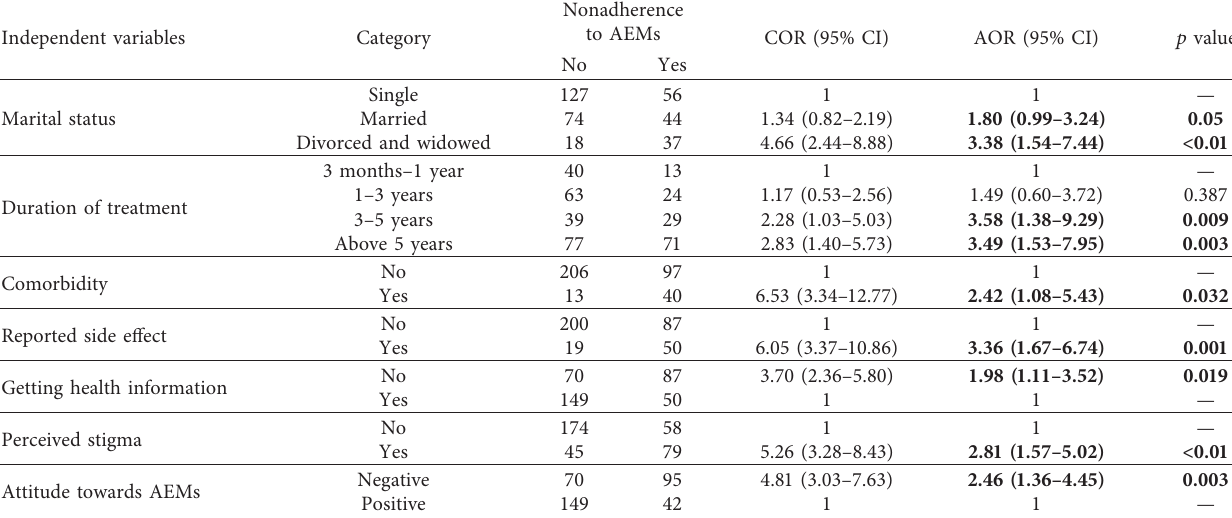
Table 4: Bivariable and multivariable analysis of factors associated with nonadherence to antiepileptic medications among epileptic patients at the University of Gondar Referral Hospital, Northwest Ethiopia, 2018 ( n � 356).